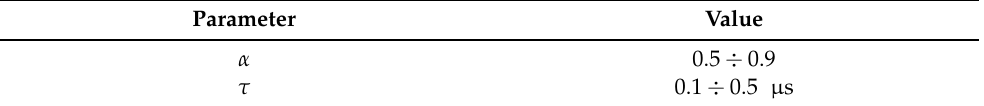
Table 3. Typical values of the input parameters required by Malik’s model. Parameter Value α 0.5 ÷